Question: How would you classify this visualization?
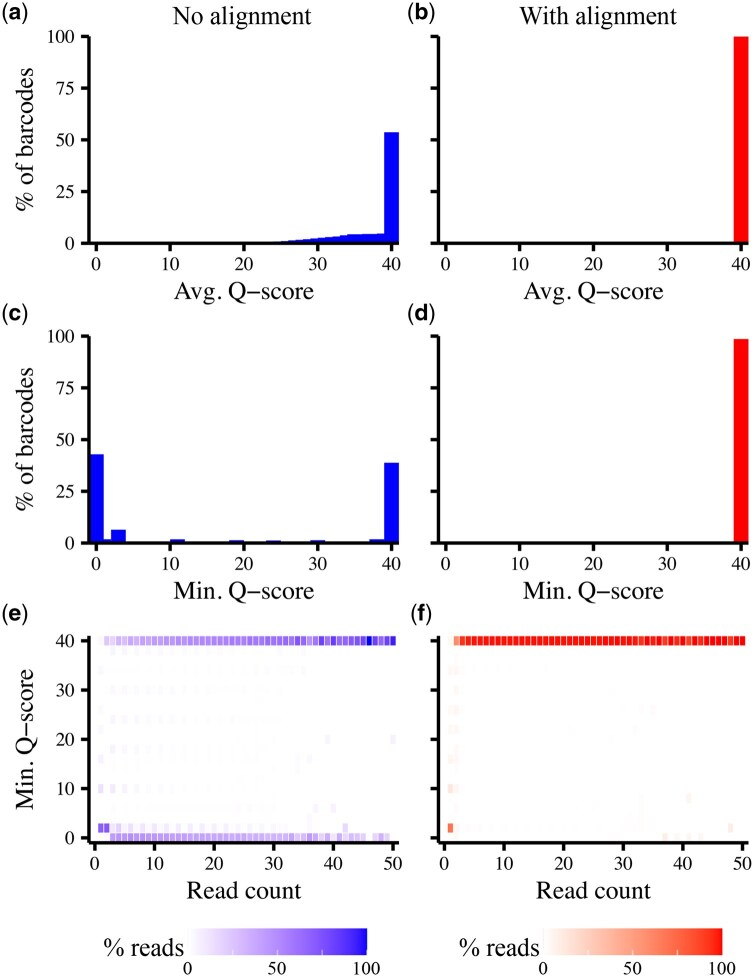
Answer: heatmap